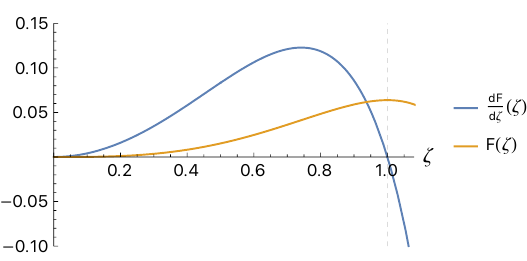
Figure 1 . The free energy is 0 when ζ = 0 , grows with ζ , and reaches its maximum at ζ = 1 . We plot the d = 3 case. The blue curve is the derivative of the free energy with respect to ζ and the orange curve is the free energy